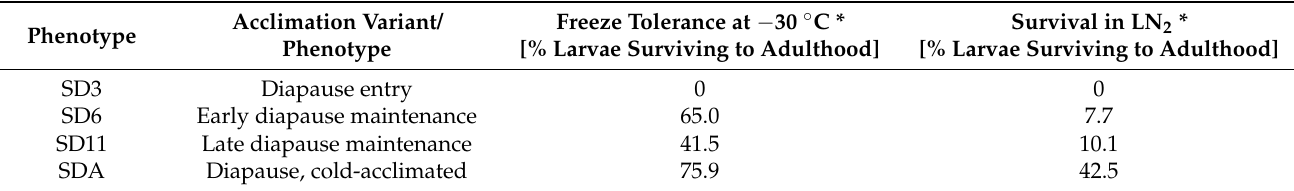
Table 1. Freeze-tolerance phenotypes of Chymomyza costata